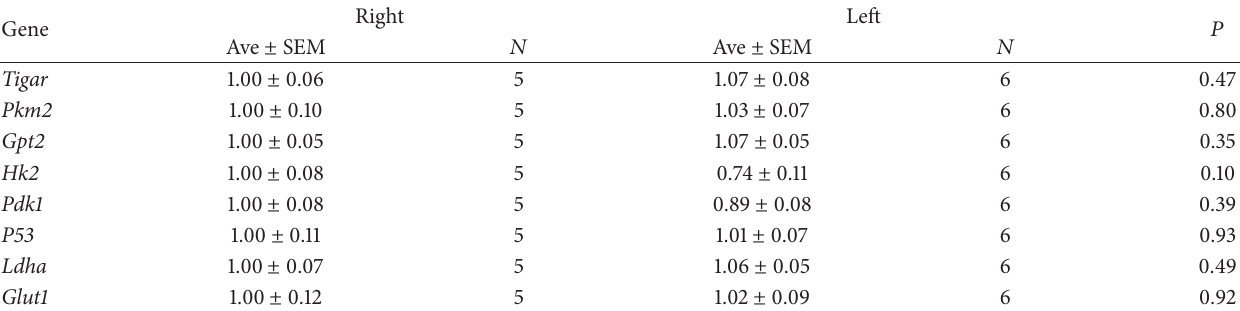
Table 4: Relative expression of genes related to Warburg